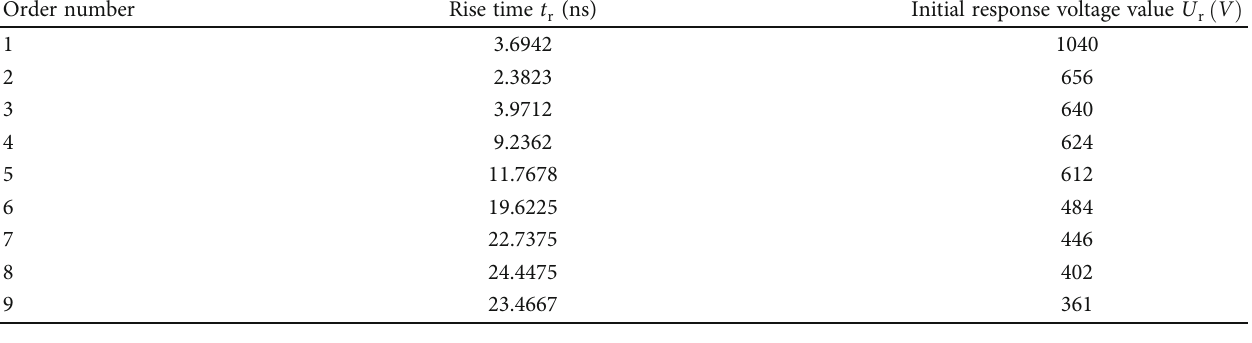
Table 3: Corresponding data relationship between initial response voltage value and pulse rise time.